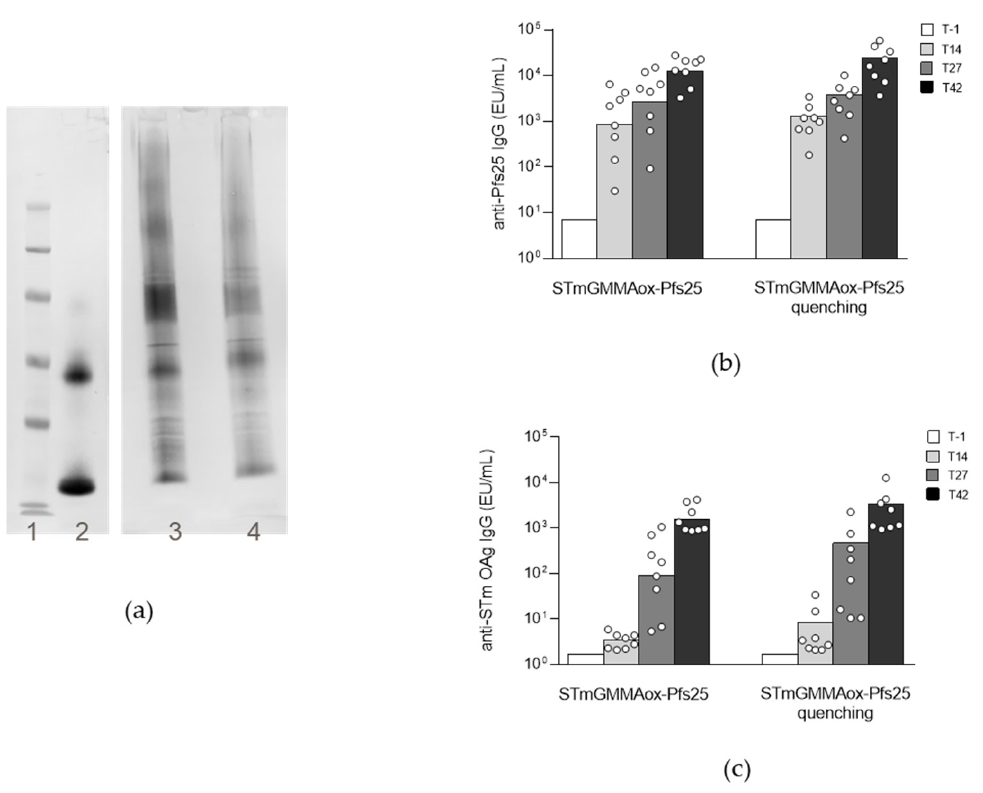
Figure 7. Further simplification of the reductive amination chemistry by introducing a NaIO 4 quenching step. ( a ) Characterization by WB analysis of the conjugates in comparison to corresponding unconjugated Pfs25. Ten µ g of conjugates and 2 µ g of protein were loaded per well. Lane 1: marker, lane 2: Pfs25, lane 3: STm GMMAox-Pfs25, lane 4: STm GMMAox-Pfs25 quenched. ( b , c ) Comparison in mice of GMMAox-Pfs25 conjugates prepared with or without the quenching step. CD1 female mice were immunized subcutaneously at days 0 and 28 with 2.5 µ g total protein dose. Both conjugates were formulated with 0.7 mg/mL Alhydrogel. Sera were analyzed at days − 1, 14, 27 and 42 by ELISA using as coating antigens Pfs25 ( b ) or STm OAg ( c ). Summary graphs of anti-antigen specific IgG geometric mean units (bars) and individual antibody levels (dots) are reported.